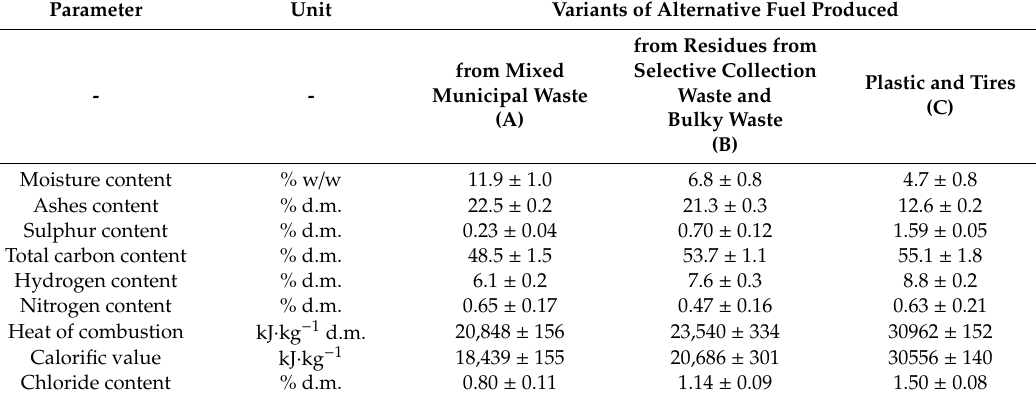
Table 3. Summary of the basic energy characteristics of refuse-derived fuel (RDF) after the biodrying process (own